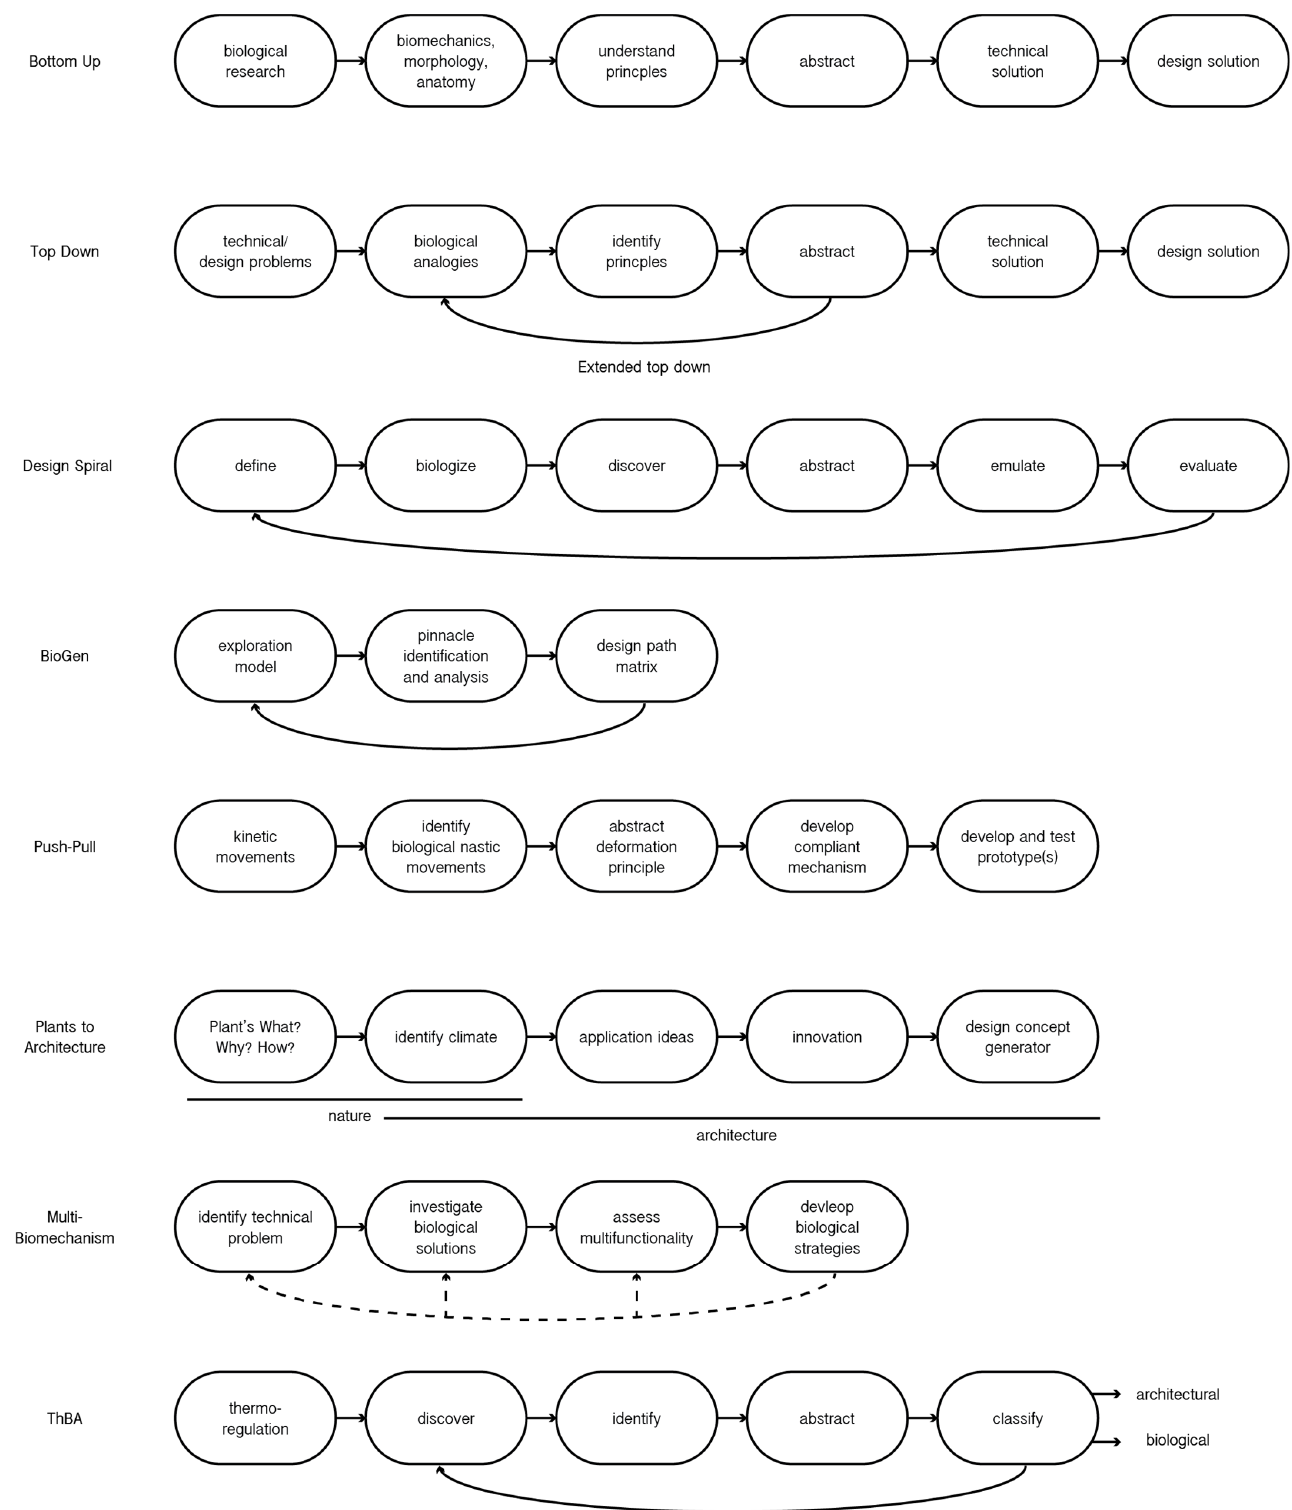
Figure 2. Simplified stages of biomimetic approaches described in Section 4.2. From top towards bottom [adapted from]: Bottom Up [3], Top Down [3], Design Spiral [19], BioGen [102], Push-Pull [103], Plant to Architecture [104], Multi-Biomechanism [105], and ThBA [106].